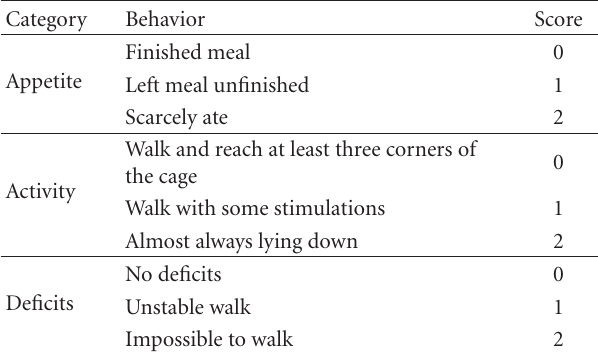
Table 1: Behavior and activity